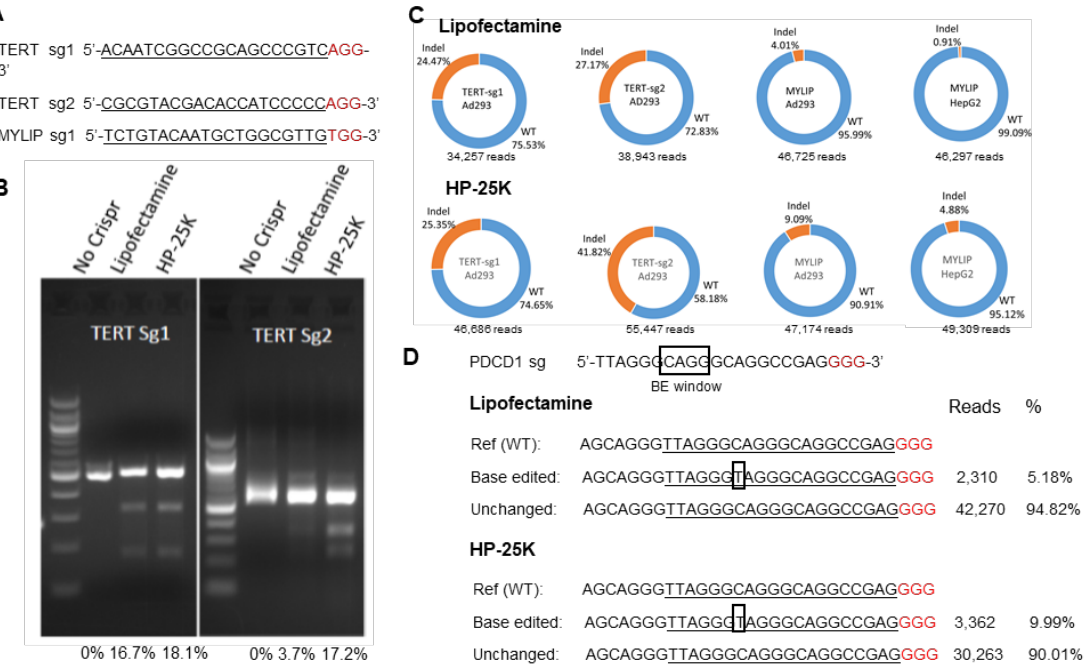
Figure 4. HP-25K nanoparticle mediated delivery of Cas9 and BE pDNAs to cells leads to efficient gene editing. ( A ) List of gRNAs used with Cas9 pDNAs. ( B ) T7E1 assay on Ad293 cells transfected with Cas9 pDNAs targeting TERT gene by HP-25K or Lipofectamine. ( C ) Deepseq analysis of